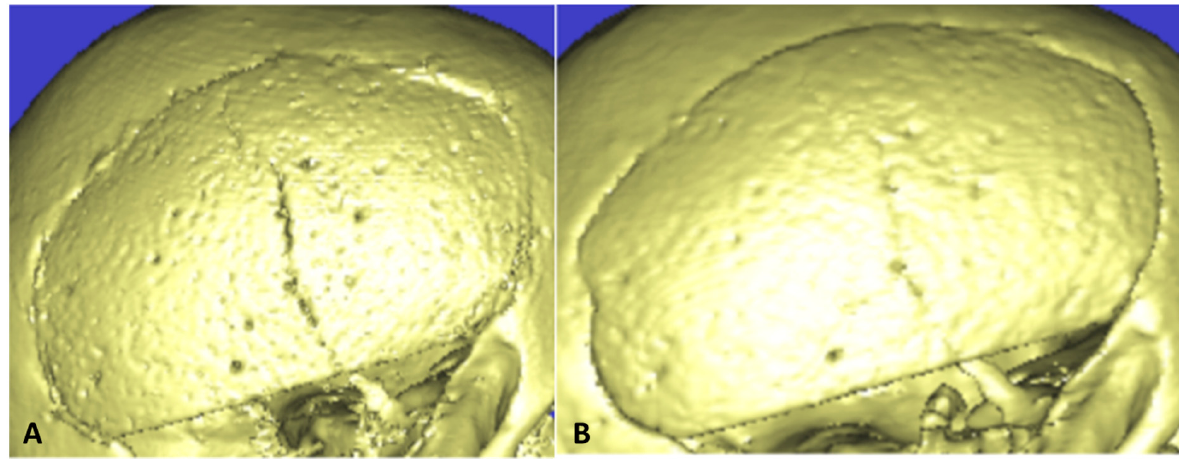
Figure 2. A female patient aged 32 years was admitted in the neurosurgical service after a decom- pressive craniectomy for a stroke of the middle cerebral artery (MCA). The patient was implanted with the autologous bone 6 months after the first surgery, but she underwent a revision surgery for bone reabsorption. After a multidisciplinary discussion, the neurosurgeon decided to implant the patient with a PHA cranioplasty. The surgical implantation was uneventful. At the first follow-up of three months ( A ), there was a sign on the CT-scan of an asymptomatic fracture. The neurosurgeon decided to not operate. A follow-up after 7 months showed a complete bone healing without surgical intervention ( B ).